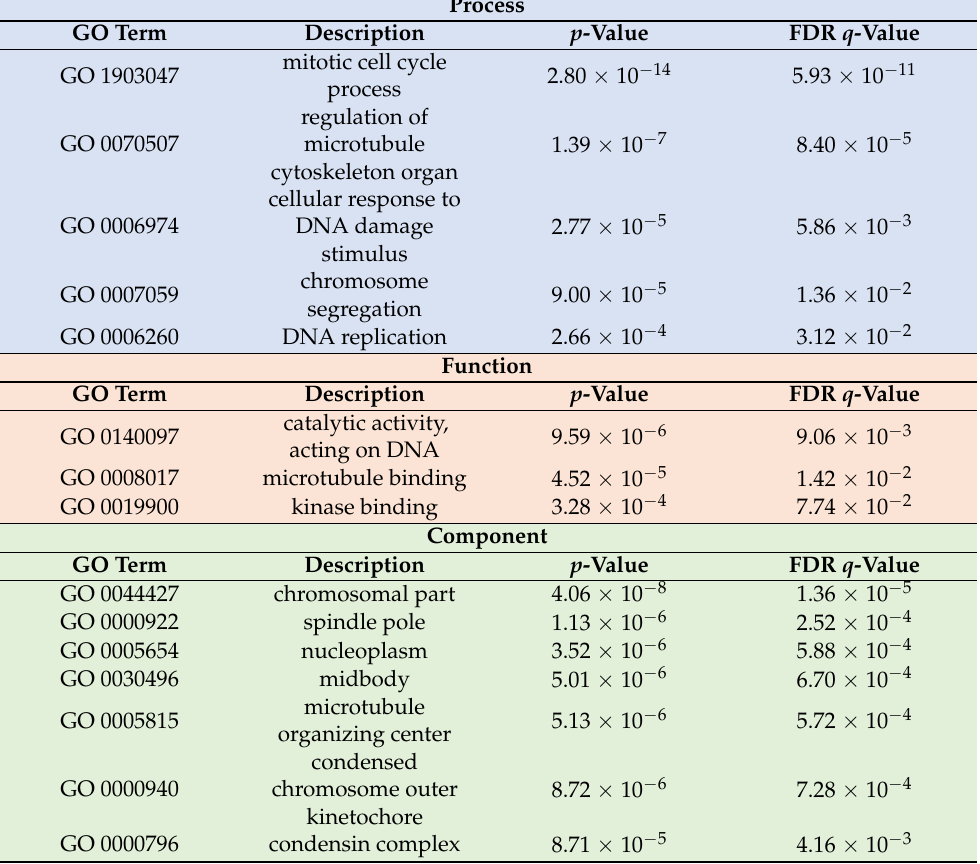
Table 1. Gene ontology (GO) term analysis of the top 2% co-expressed genes of RNASEH2A reveals the possible role of RNASEH2A in cell cycle regulation. The analysis shows RNASEH2A functional networks based on process (blue panel), function (orange panel), and component (green panel). The analysis was made by Gene Ontology enRichment anaLysis and visuaLizAtion tool (GOrilla). Statistic is shown by both p -value and false discovery rate